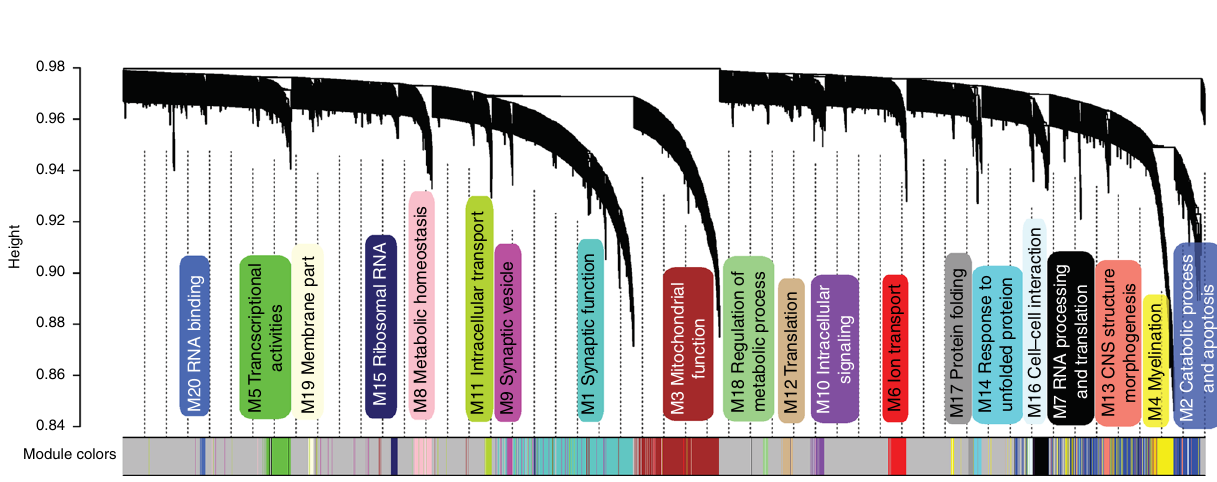
The table summarizes gene ontology (GO) and cell-type enrichment analysis for the 232 cognitive trajectory-associated proteins adjusting for β -amyloid and neuro fi brillary tangle pathology. Differentially abundant proteins are categorized as either low- or high-abundance in cognitive stability. The underlying data are provided as a Supplementary Data